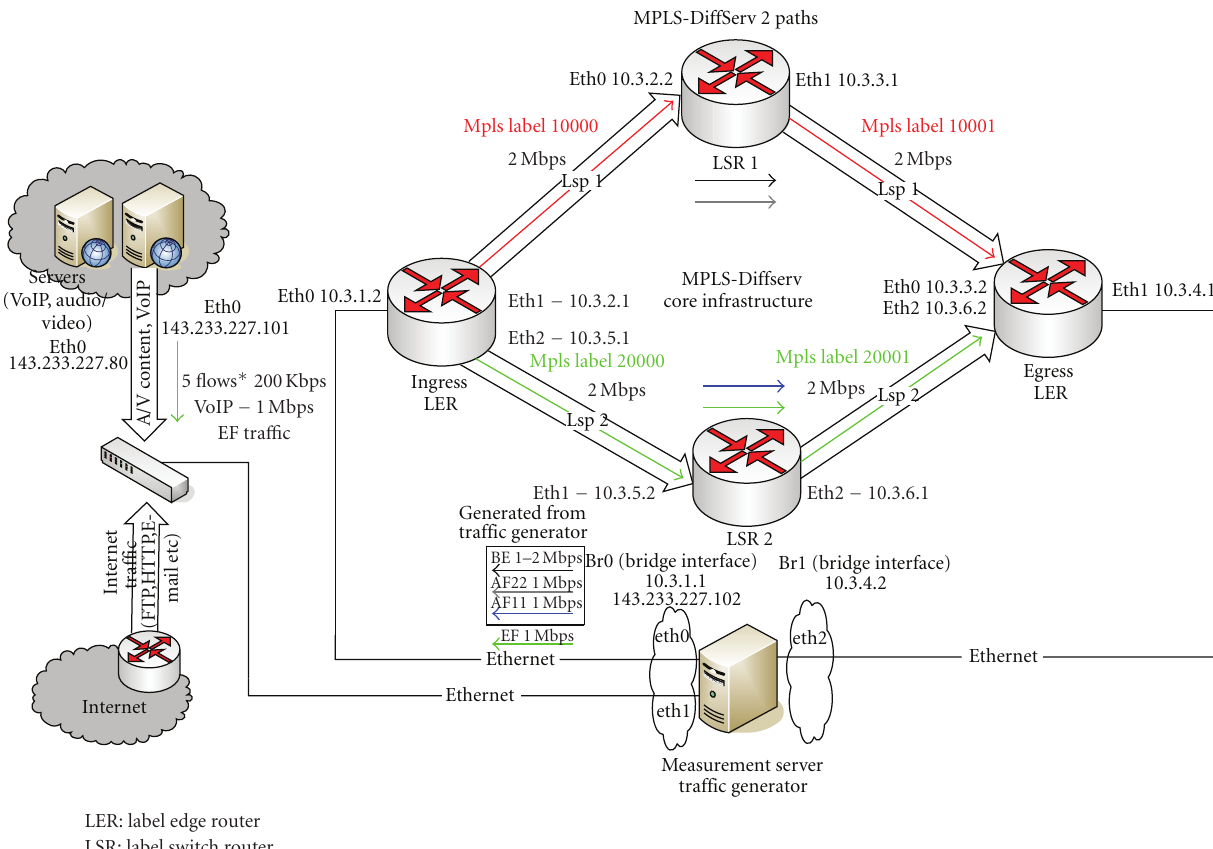
Figure 8: Core network with MPLS-Di ff Serv QoS enabled 2